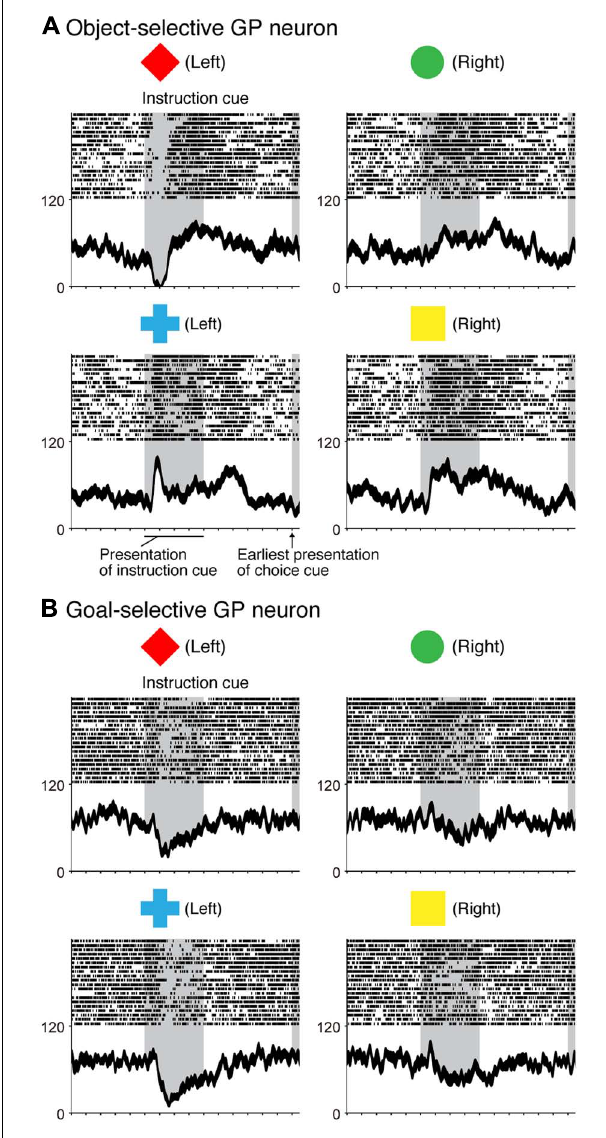
FIGURE 12 |Two examples of neurons in the GP selective for a visual object and a behavioral goal in the symbolic cue task. (A) Activity of this GP neuron decreased when a red diamond was presented as an instruction cue, whereas it increased when a blue cross was presented as an instruction cue. (B) Activity of this GP neuron decreased when either a red diamond or a blue cross was presented. Neuronal activity was aligned with the onset of the instruction cue.The gray areas on the left indicate when the instruction was presented, and the gray areas on the right represent the earliest presentation of the choice cue.The tick marks on the horizontal axis are placed at 200-ms intervals.The display formats are the same as those used in Figure 7 (adapted from Arimura etal.,